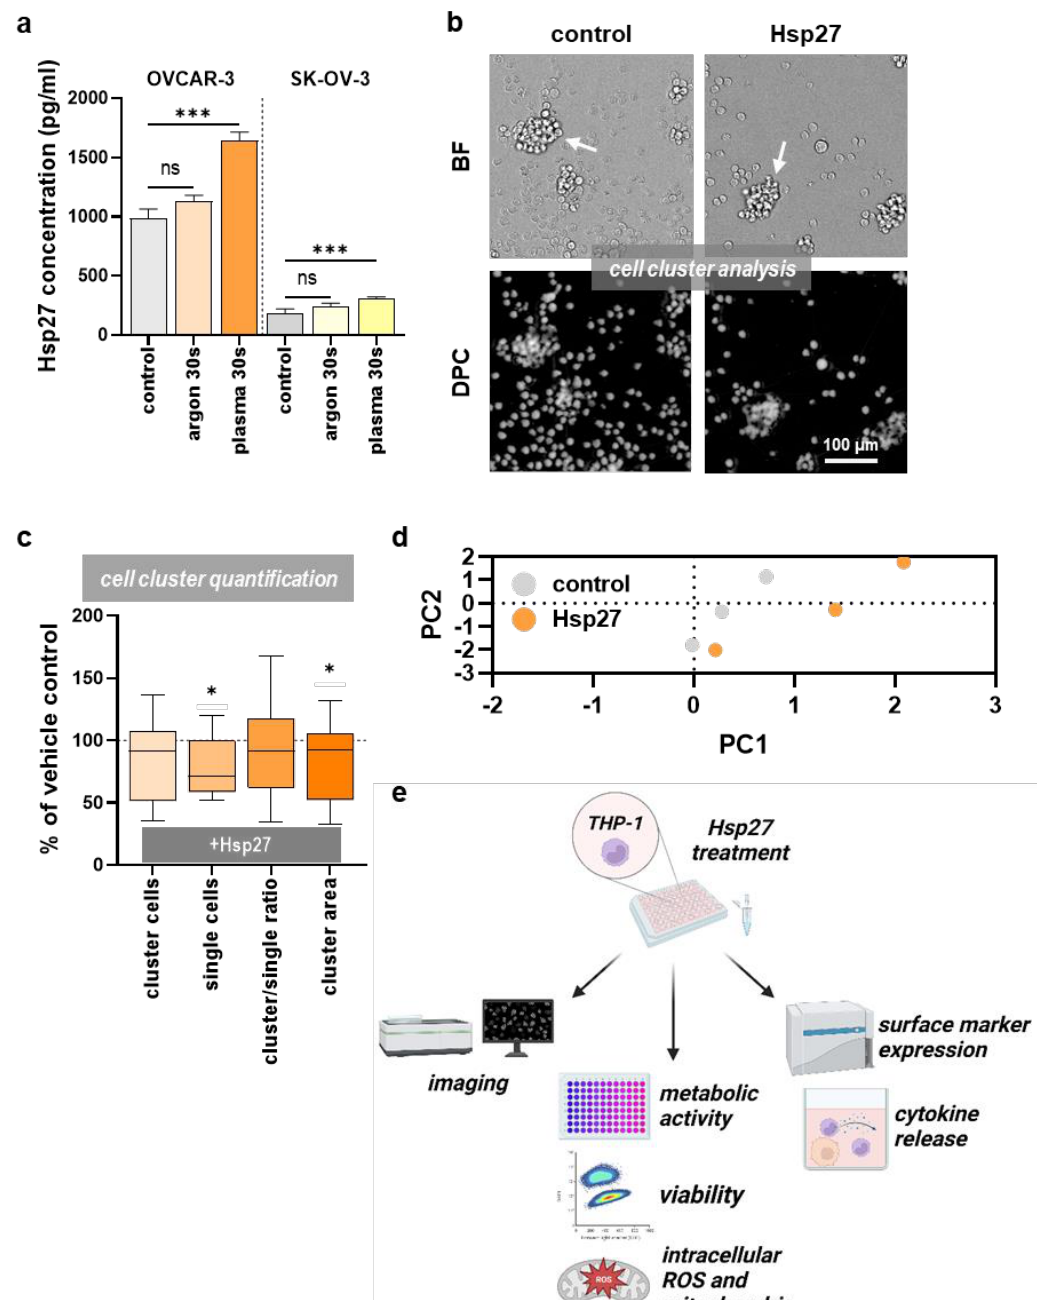
Figure 1. Hsp27 release in ovarian cancer cells and effects on the THP-1 cells. ( a ) Hsp27 release 24 h after 30 s argon plasma treatment in OVCAR-3 and SK-OV-3 cells; ( b ) representative images of untreated (control) and Hsp27-incubated THP-1 cells captured in the brightfield (BF) and digital phase contrast (DPC) channel 144 h after treatment; clusters are indicated with white arrows; ( c ) algorithm-based quantification of THP-1 cell cluster properties 144 h after addition of Hsp27 compared to the vehicle-treated (solvent control) cells for the parameter’s cluster cells, single cells, cluster over single cell ratio, and total cluster cell area, showing a significant decrease in the second and fourth metric caused by Hsp27; ( d ) principal component analysis of vehicle (grey) and Hsp27 (orange) treated THP-1 cells taking into account multiple morphological features as extracted using Harmony quantitative imaging software; ( e ) study-protocol of further Hsp27 exposure to the THP-1 cells. Statistical analysis was performed using one-way ANOVA ( a ) or using an unpaired two-tailed t -test ( c ) with p < 0.05 (*) and p < 0.001 (***). ns = not significant. Scale bar is 100 µm ( b ).